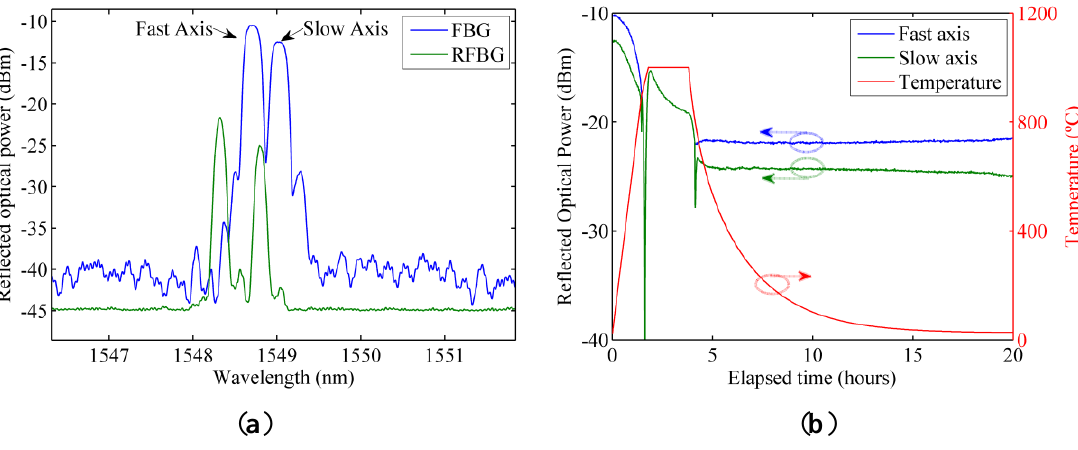
Figure 1. ( a ) Spectra of the seed FBG and RFBG; ( b ) Maximum reflected optical power of the fast and slow axis during the regeneration process.